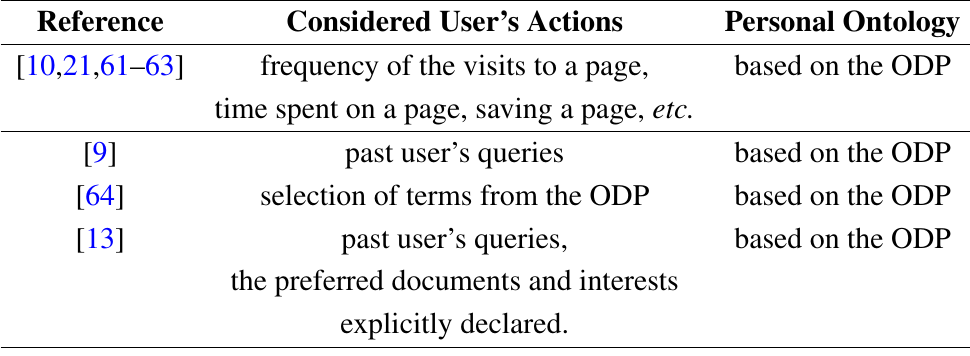
Table 2. Synthesis of the discussed methods for re-ranking of search